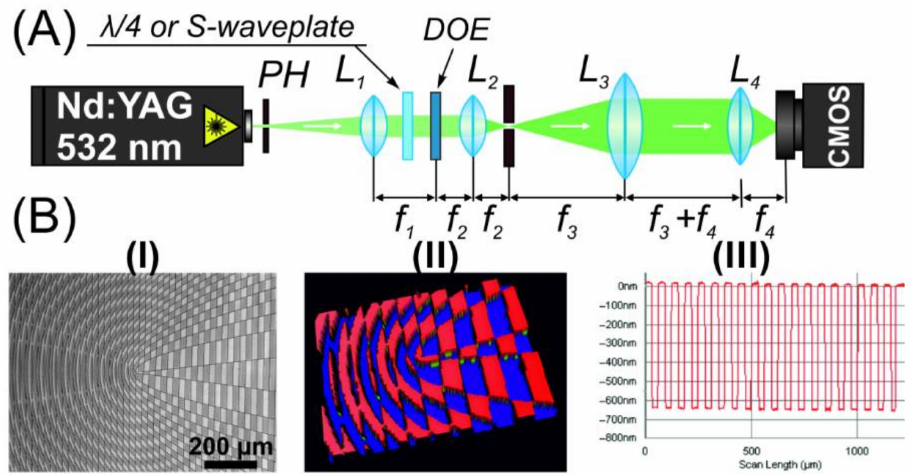
Figure 1. Experimental investigation of polarization transformation performed by the fabricated diffractive axicons and their combinations. ( A ) Experimental setup. ( B ) Example of the fabricated DOE: ( I ) an optical microscopy image, ( II ) an optical profilometry image of the central part of the manufactured element, and ( III ) a measured profile of the fabricated element along a vertical